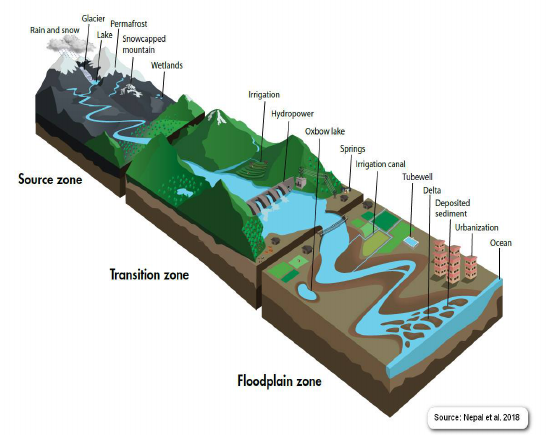
Figure 2: Schematic diagram of a river corridor showing three zones and their upstream–downstream